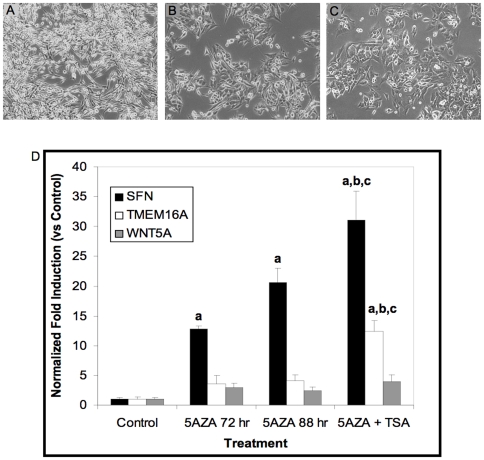
Exposure to 5-aza-2-deoxycytidine and Trichostatin A.A–C: 468LN cells were cultured for 7 days in A: the absence or B: the presence of 5-aza-2-deoxycytidine followed by C: an additional 16 h exposure to the histone deacetylase inhibitor Trichostatin A (TSA). D: Induction of epigenetically down-regulated genes. 468LN cells were cultured in the absence (Control) or presence of 5-aza-2-deoxycytidine (5AZA) for 72 hours (5AZA 72 hr), 88 hours (5AZA 88 hr), or for 72 hours followed by the addition of Trichostatin A (TSA) for 16 hours (5AZA+TSA). Total RNA was extracted and qRT-PCR performed as described in the text. Significant group differences were determined using ANOVA followed by the Student-Newman-Keuls multiple comparison procedure. a: significantly different (p<0.05) vs Control. b: significantly different vs 5AZA 72 hr. c: significantly different (p<0.05) vs 5AZA 88 hr.